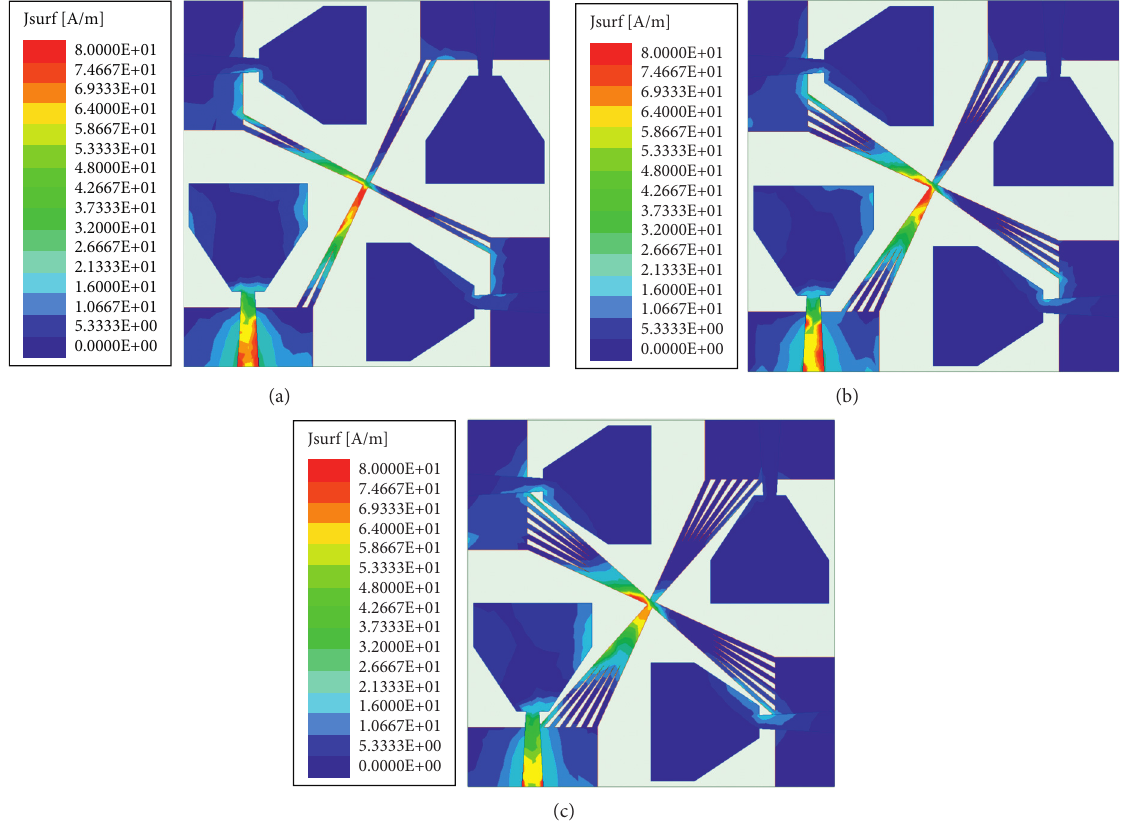
Figure 14: Surface current distribution diagrams of three four-port antenna structures at 5GHz. (a) Two stubs. (b) Four stubs. (c) Six